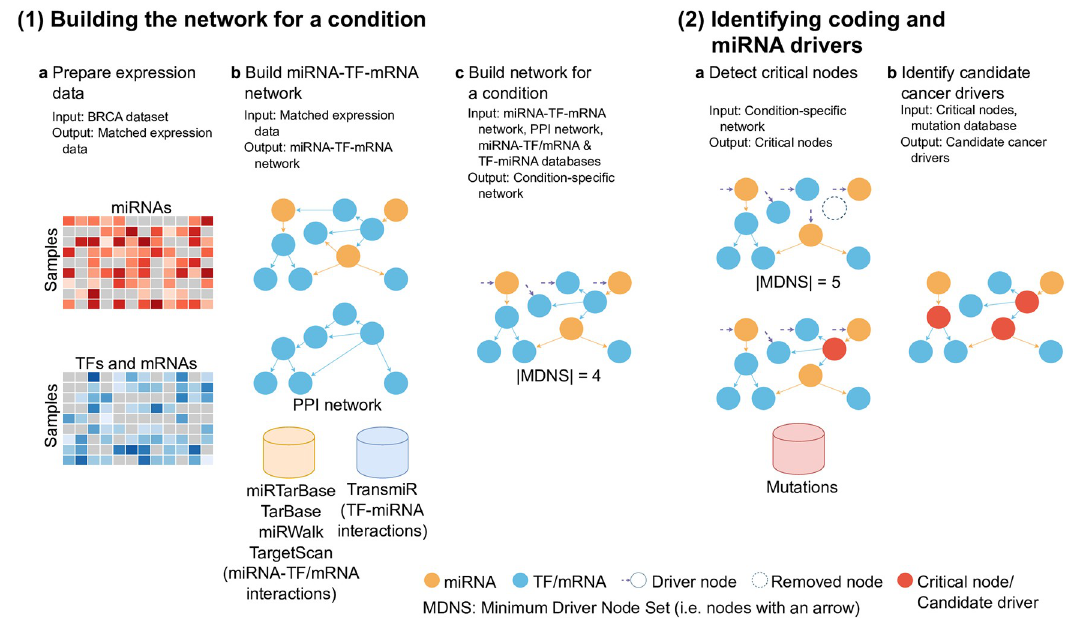
Fig 2. An illustration of CBNA. (1) Building the network for a condition: (a) Prepare matched miRNA and TF/mRNA expression data, (b) Build miRNA-TF-mRNA network where nodes represent miRNAs/TFs/mRNAs and an edge between two nodes indicates there is a significant Pearson correlation between the expression of the two nodes, (c) Create the network by combining the miRNA-TF-mRNA network with the PPI network and other existing databases, and (2) Identifying coding and miRNA drivers: (a) Detect critical nodes, (b) Identify candidate cancer